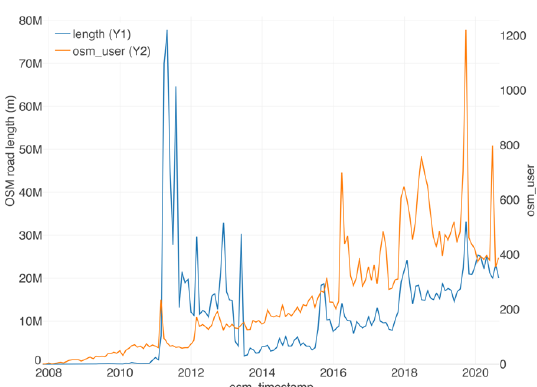
Figure 2. Monthly OpenStreetMap road updates and number of participating